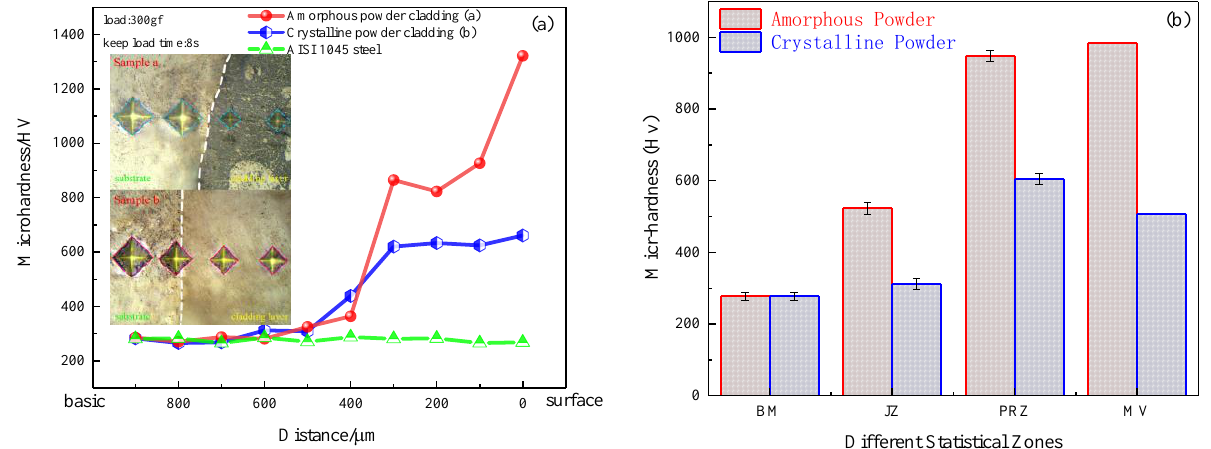
Figure 8. The distribution of the microhardness of the two cladding samples compared with AISI 1045 steel. ( a ) Microhardness curve of the two cladding samples; ( b ) Histogram of average microhardness in basic matrix, junction zone, powder remelting zone and mean value of the two cladding samples.